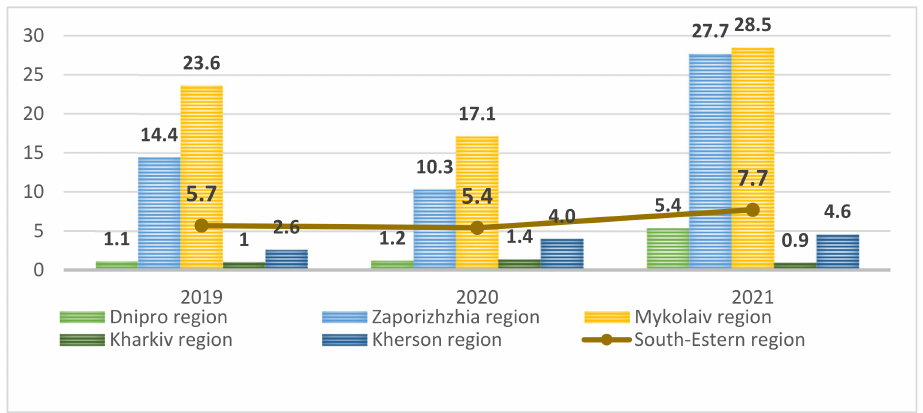
Figure 7. Coefficient of production efficiency of KI use in the RES sector in terms of the south- eastern region of Ukraine in 2019–2021, per kWh/USD (constructed by the authors according to the data